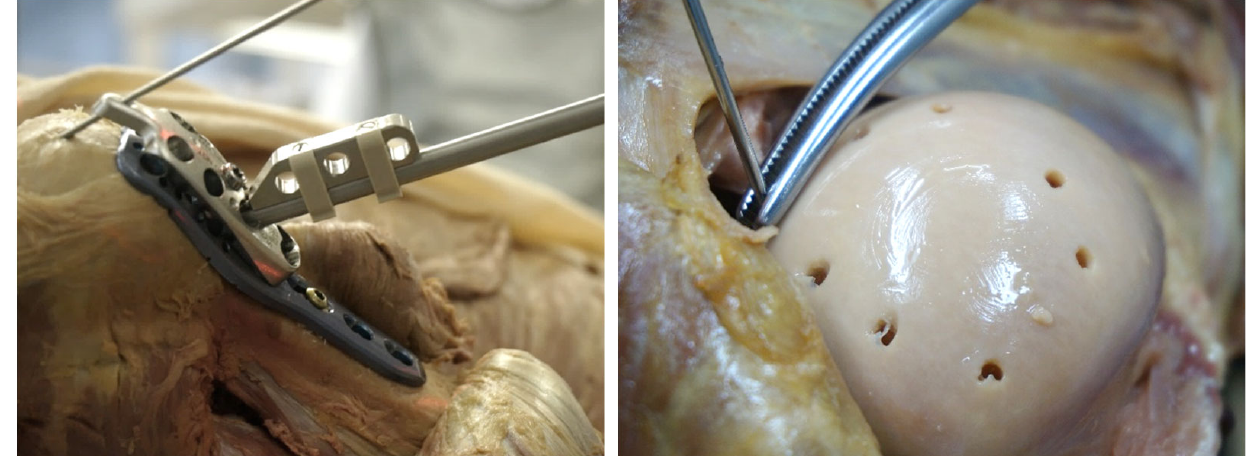
Figure 1. Postmortem experiment. ( Left ): Reference marker clip attached to a conventional drill sleeve and positioned in the center hole of the PHILOS plate (screw 7, D-level) with guide block. Three Xin1 tracking holes arranged in a defined pattern are integrated in the marker body. ( Right ): Over-drilled pilot holes after dislocation of the humeral head. A K-wire was inserted until touching the screw tip to measure the tip-to-joint distance (TJD).